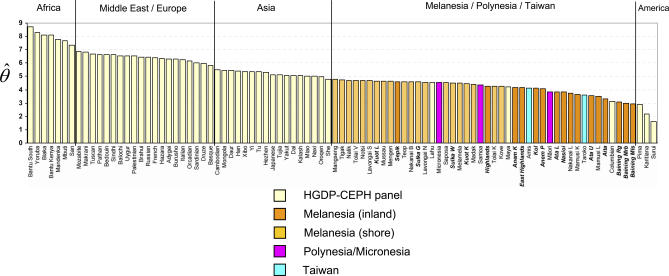
Population DiversityValues of θ̂ for the HGDP-CEPH and Pacific datasets, for 687 microsatellites. Populations are ordered by their declining values of θ̂, but systematic regional distinctions are indicated by vertical lines. Conglomerate groups tend to have higher values than nearby populations (Bantu South, Sepik, Highlands, Micronesia, Samoa, and Columbia). Papuan-speaking groups are in bold italics; the Melanesian inland/shore distinction is indicated by the two shades of orange. Abbreviated names are spelled out in Table S1.